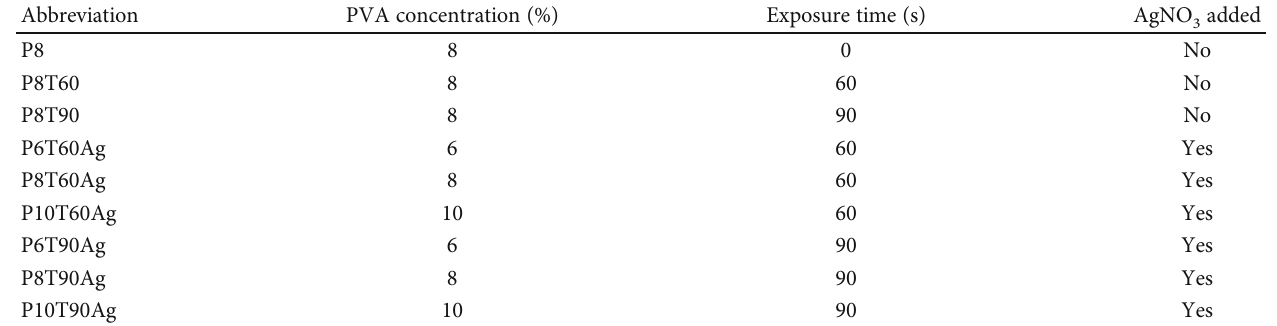
Table 1: List of samples.